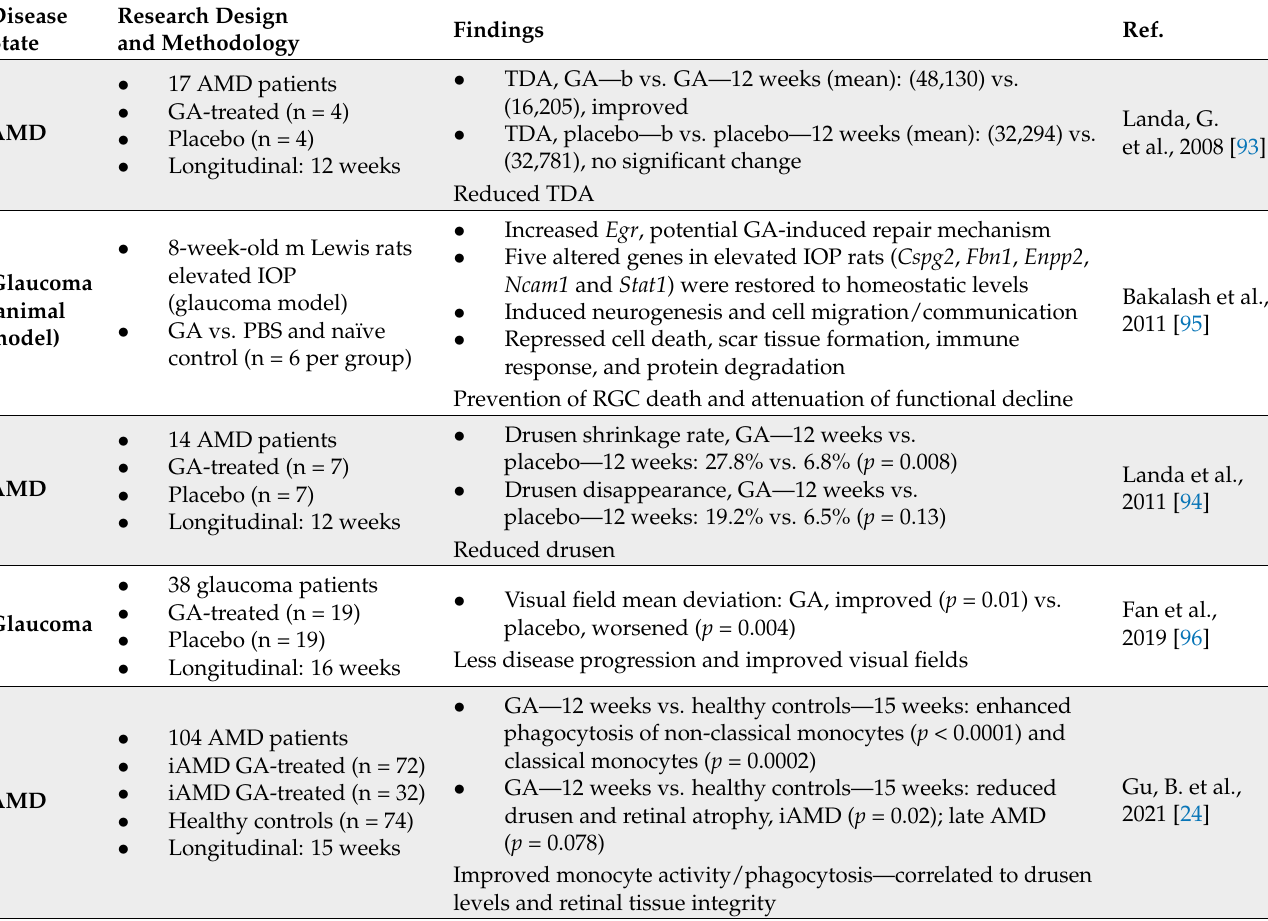
Table 2. Clinical Trials and an Animal Model Examining Alternative Outcome of Glatiramer Acetate Treatment in Ophthalmological